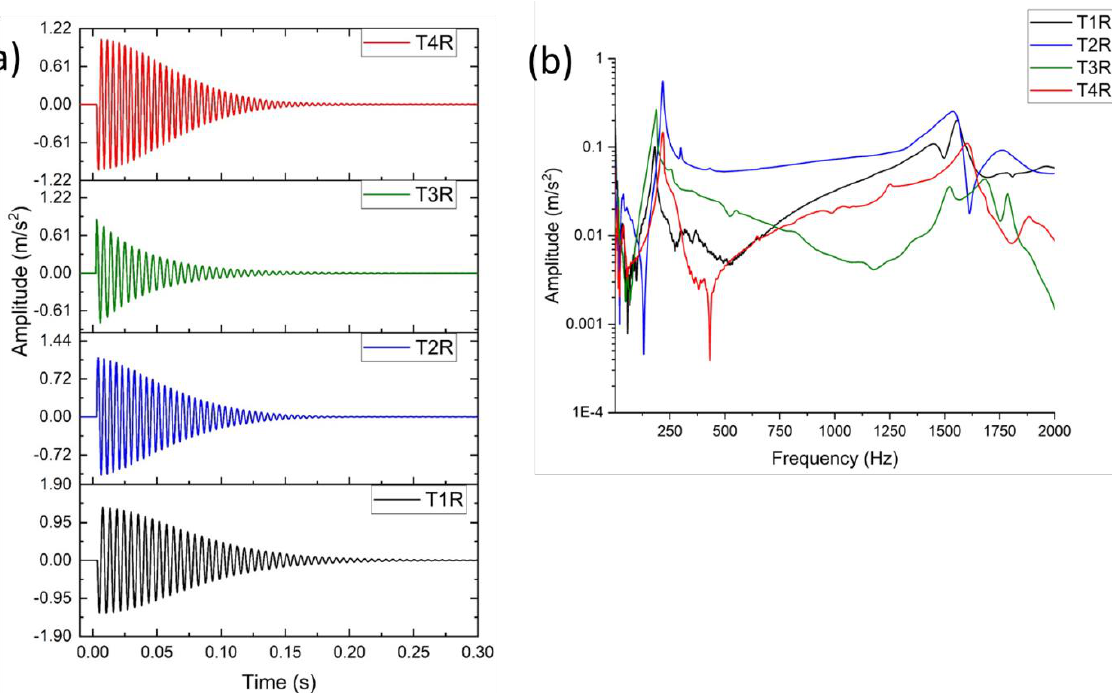
Figure 4. The dynamic response of the investigated samples without a coat. ( a ) The time-domain response of the investigated specimens. ( b ) The frequency response function FRF. Note: 1E-4 means